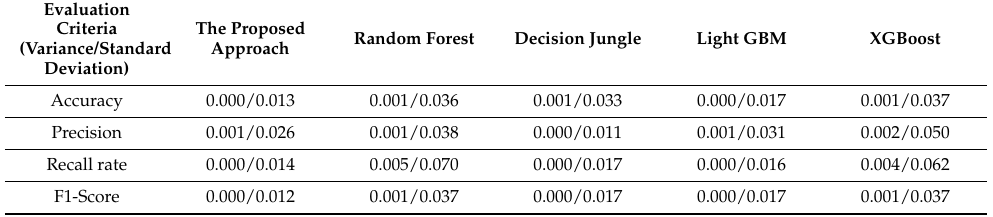
Table 3. Results of mean and variance over repeated runs from 10-fold